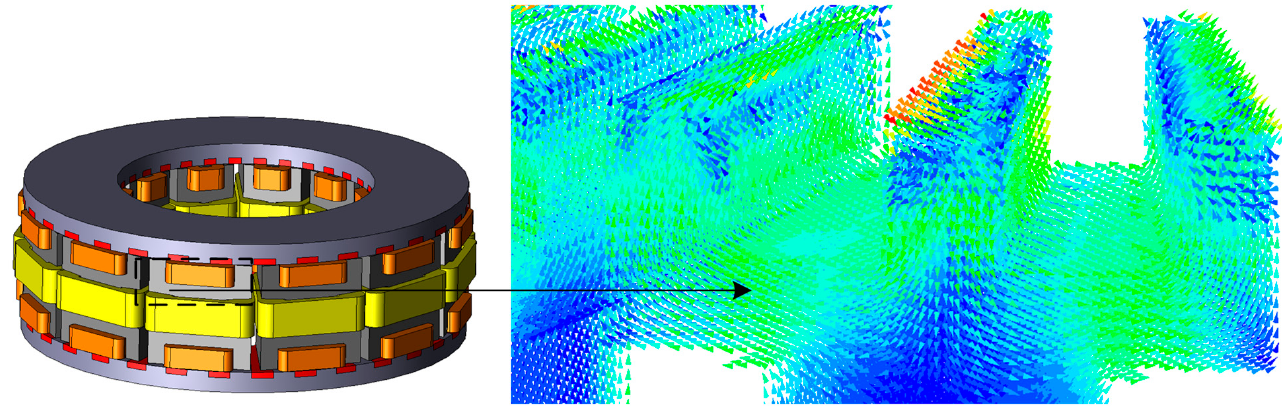
Figure 6. Flux-weakening path in stator split-teeth.